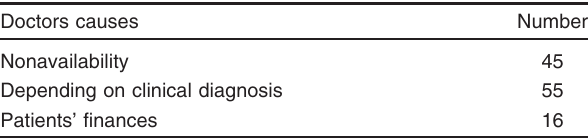
Table 11 Description of doctors according to reasons for not performing spirometry to chronic obstructive pulmonary disease patients Doctors causes